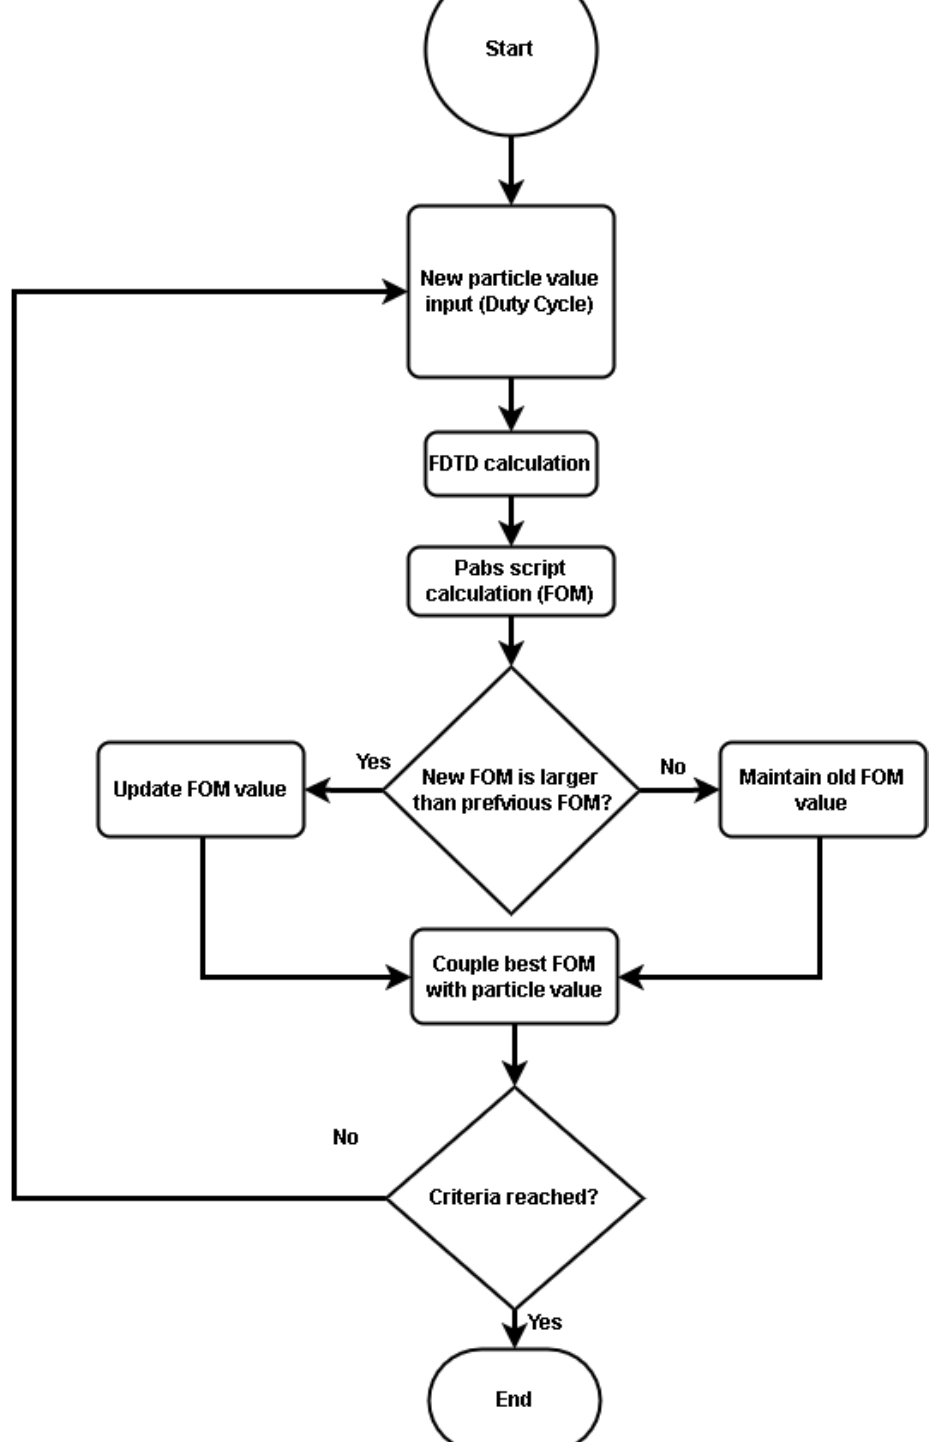
Figure 2. Particle swarm optimization (PSO) flowchart with optical power absorption (Pabs) as Figure of merit and duty cycle as the particle.